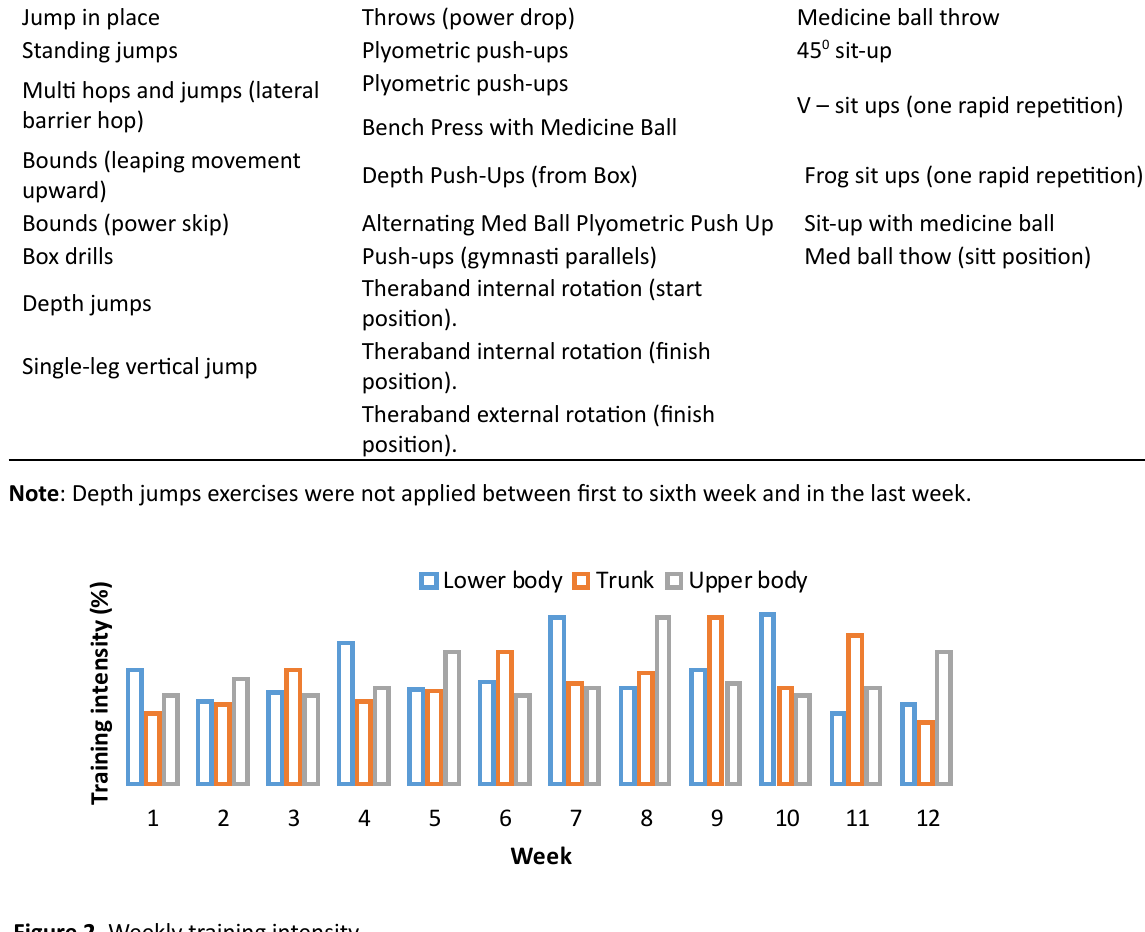
Table 1. Exercises included on the plyometric training program